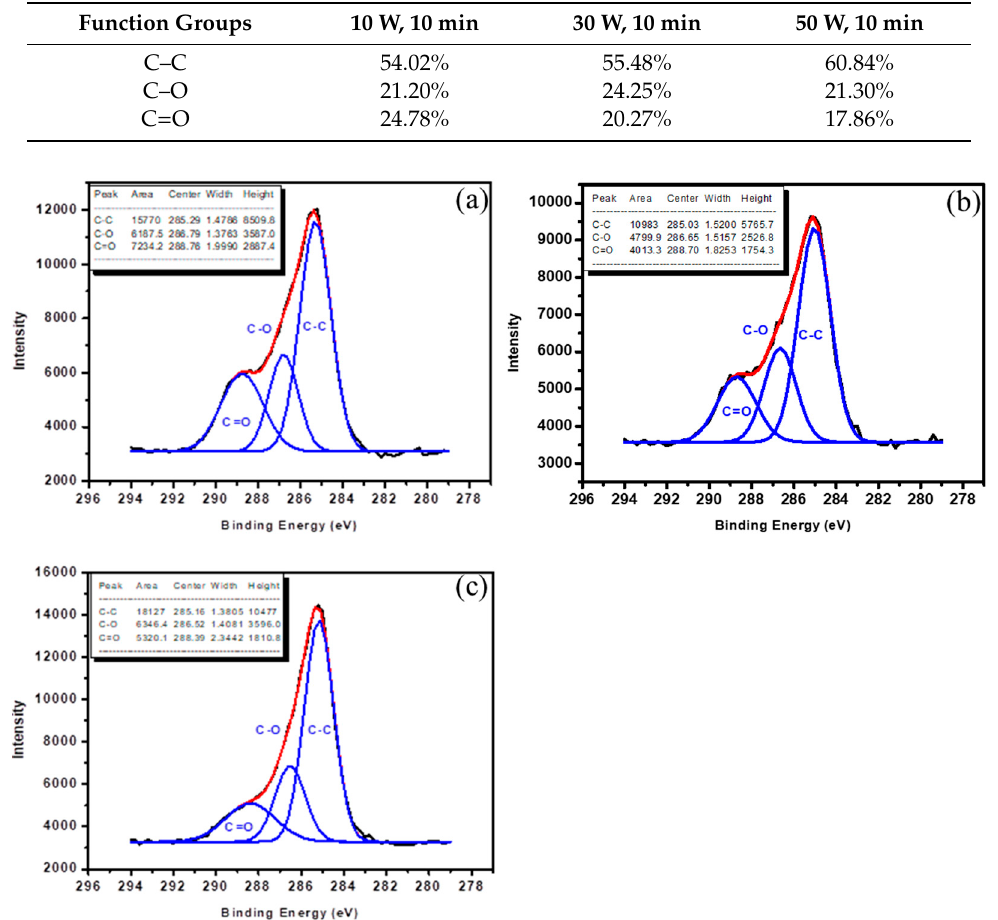
Table 4. Relative intensity (% area) of various functional groups (chemical bonds) measured by the C1s peaks from the Si wafer surfaces treated by acetic acid plasma with different conditions.